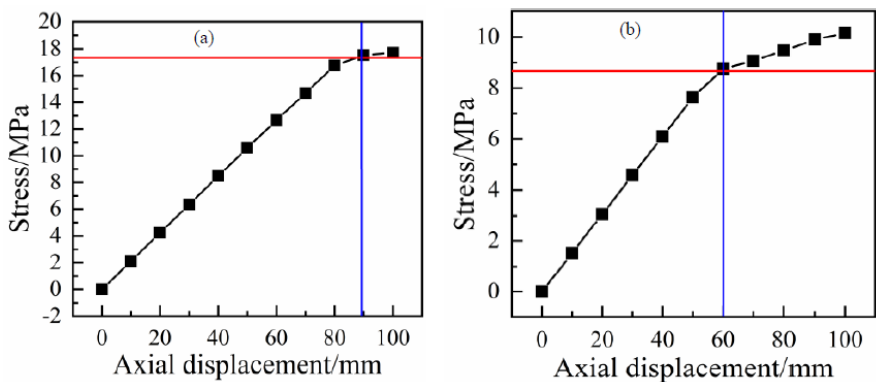
Figure 9. Curves of stress with axial tensile displacement: ( a ) inner liner; ( b ) outer cover.